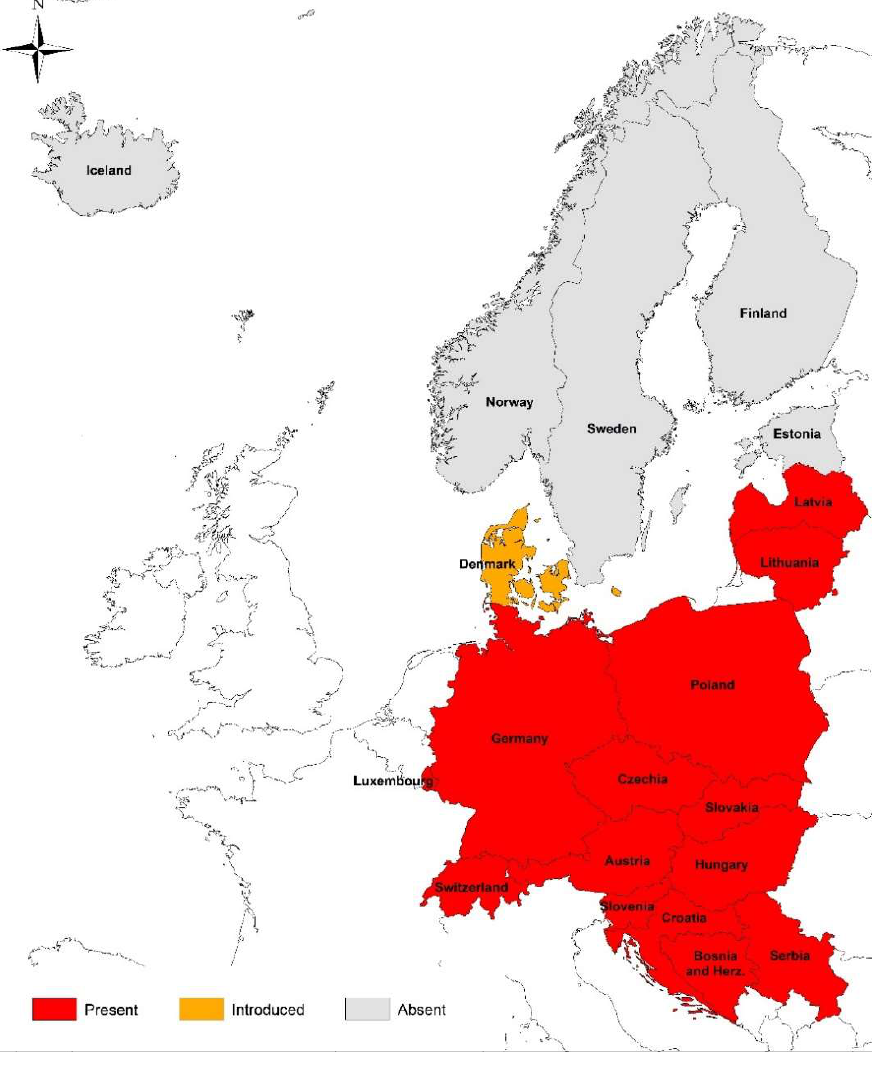
Figure 1. Occurrence of the ornate dog tick, Dermacentor reticulatus, in the reviewed countries according to https://www.ecdc.europa.eu/sites/default/files/images/Dermacentor_reticulatus_2021_09.png (accessed on 20 March 2022).